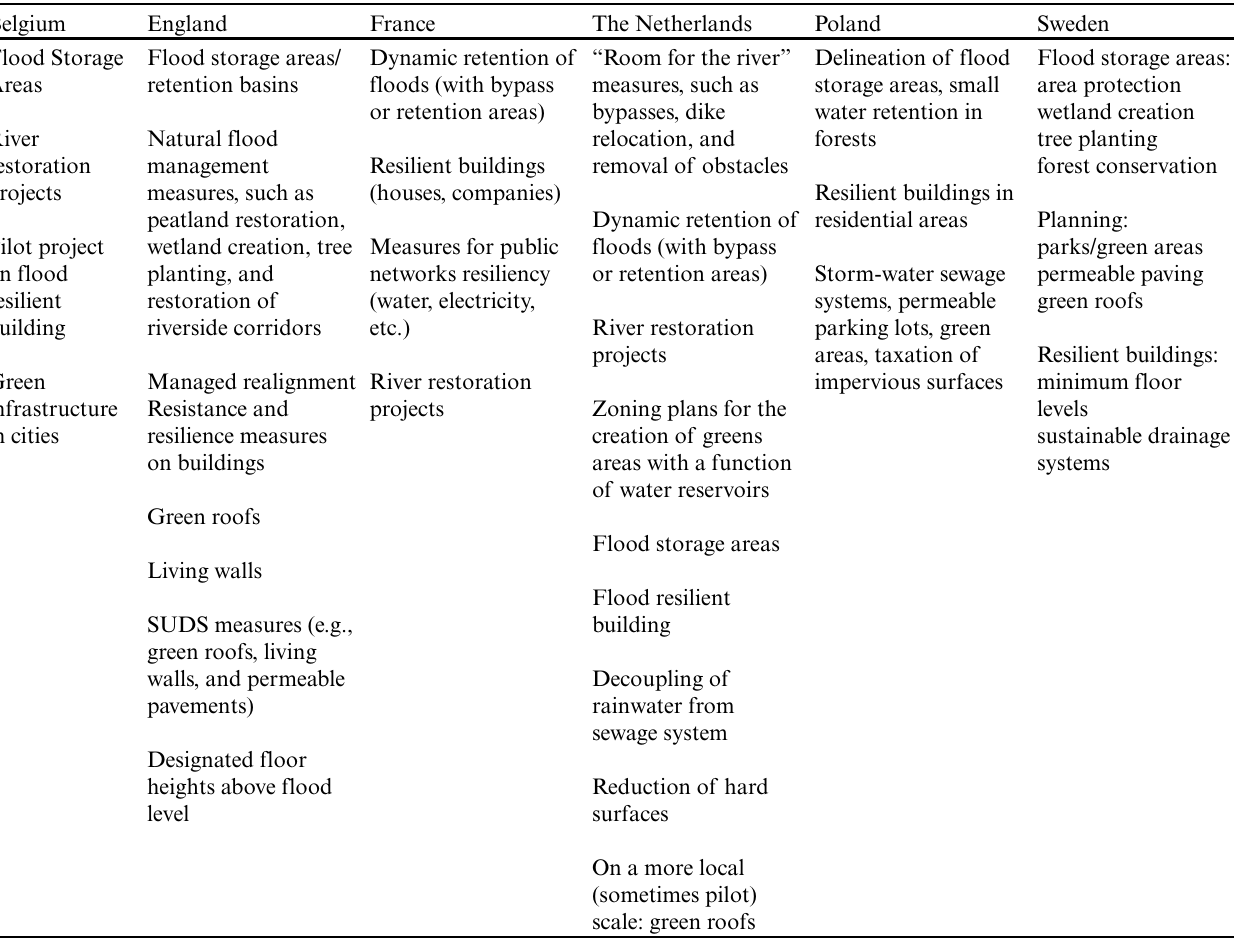
Table 2 . Main mitigation measures in the six selected countries (sources: Alexander et al. 2016, Ek et al. 2016, Kaufmann et al. 2016, Larrue et al. 2016, Matczak et al. 2016, Mees et al. 2016).